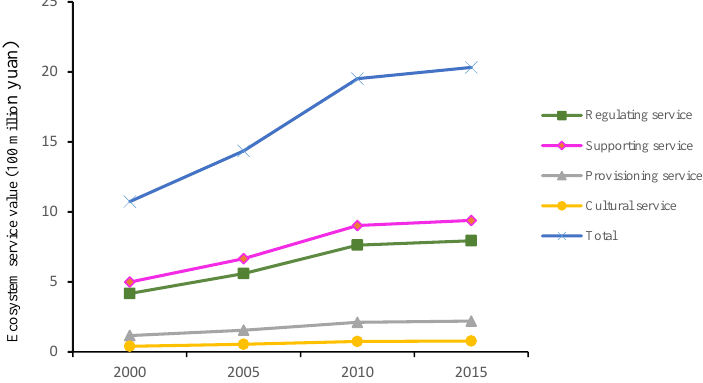
Figure 3. Ecosystem service value of Shangzhou district from 2000 to 2015.